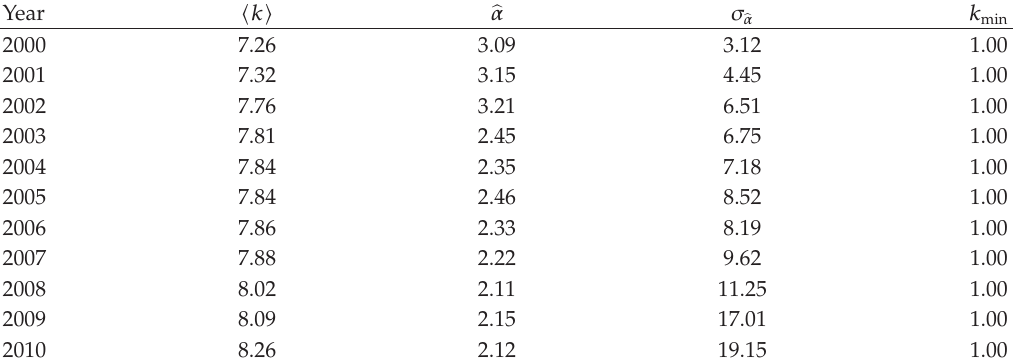
Table 1: Basic parameters of power-law distribution tests of China domestic airline networks, from year 2000 to